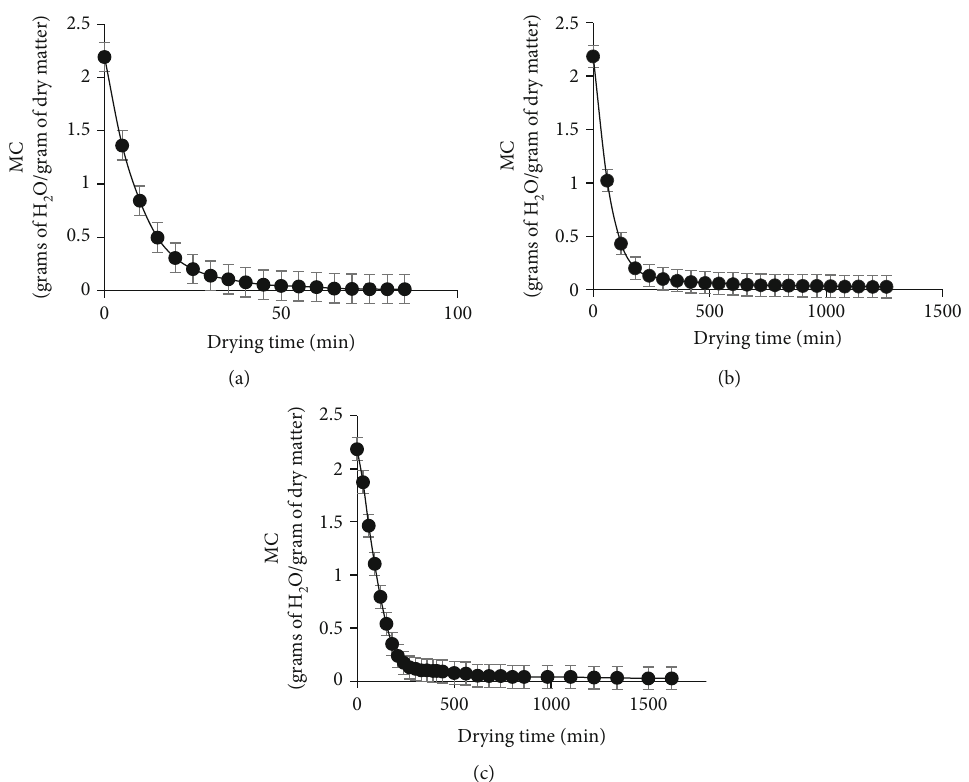
Figure 1: Variation of moisture content with drying time for refractance window drying (a), oven drying (b), and solar drying